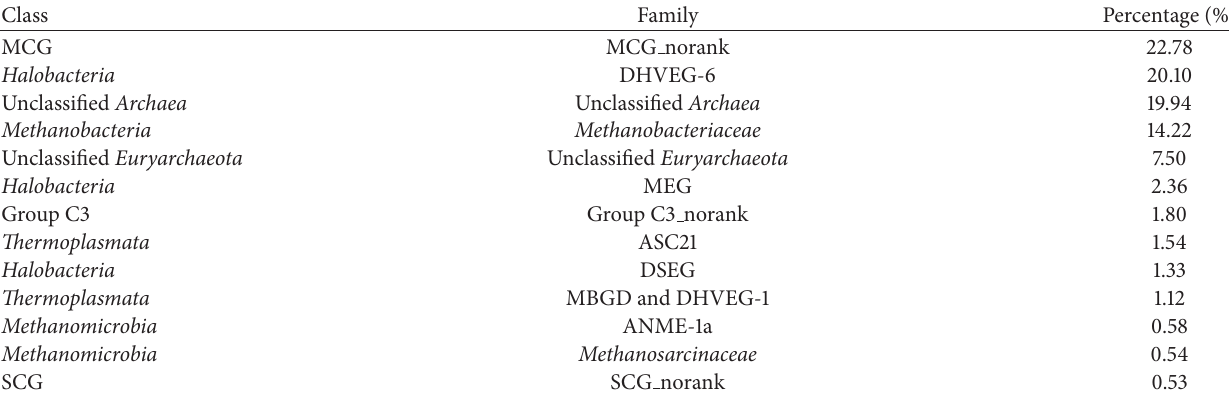
Table 2: The top 13 most abundant families in all of the samples from the five sediment